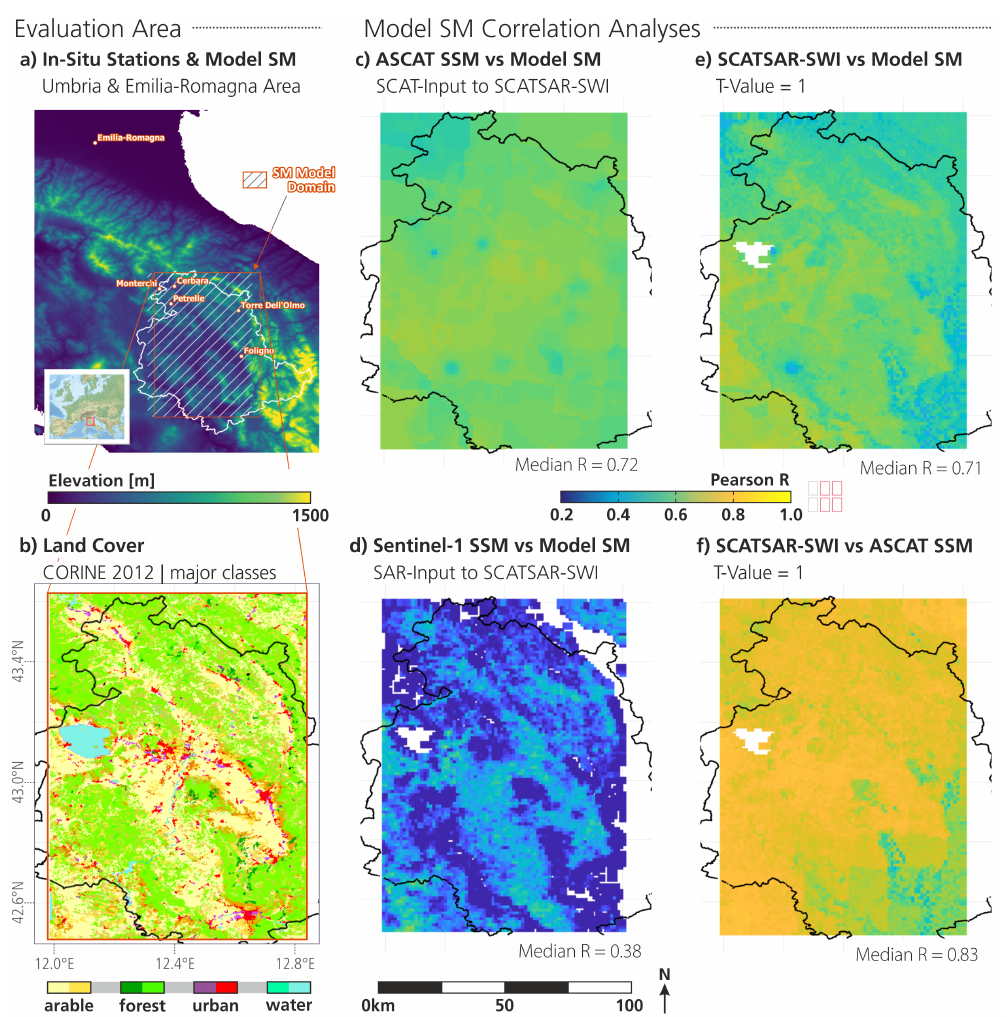
Figure 3. ( a ) evaluation area over Umbria, with Model SM domain, in situ stations, and COSMOS-station in Emilia Romagna. Elevation map as background; ( b ) CORINE Land Cover, grouped as main classes occurring in the Umbria area. Results as discussed in Section 5.2: ( c , d ) comparison of the input SSM datasets with Model SM, showing the Pearson R over the model domain; ( e ) comparison of the SCATSAR-SWI with Model SM; and with ASCAT SSM ( f